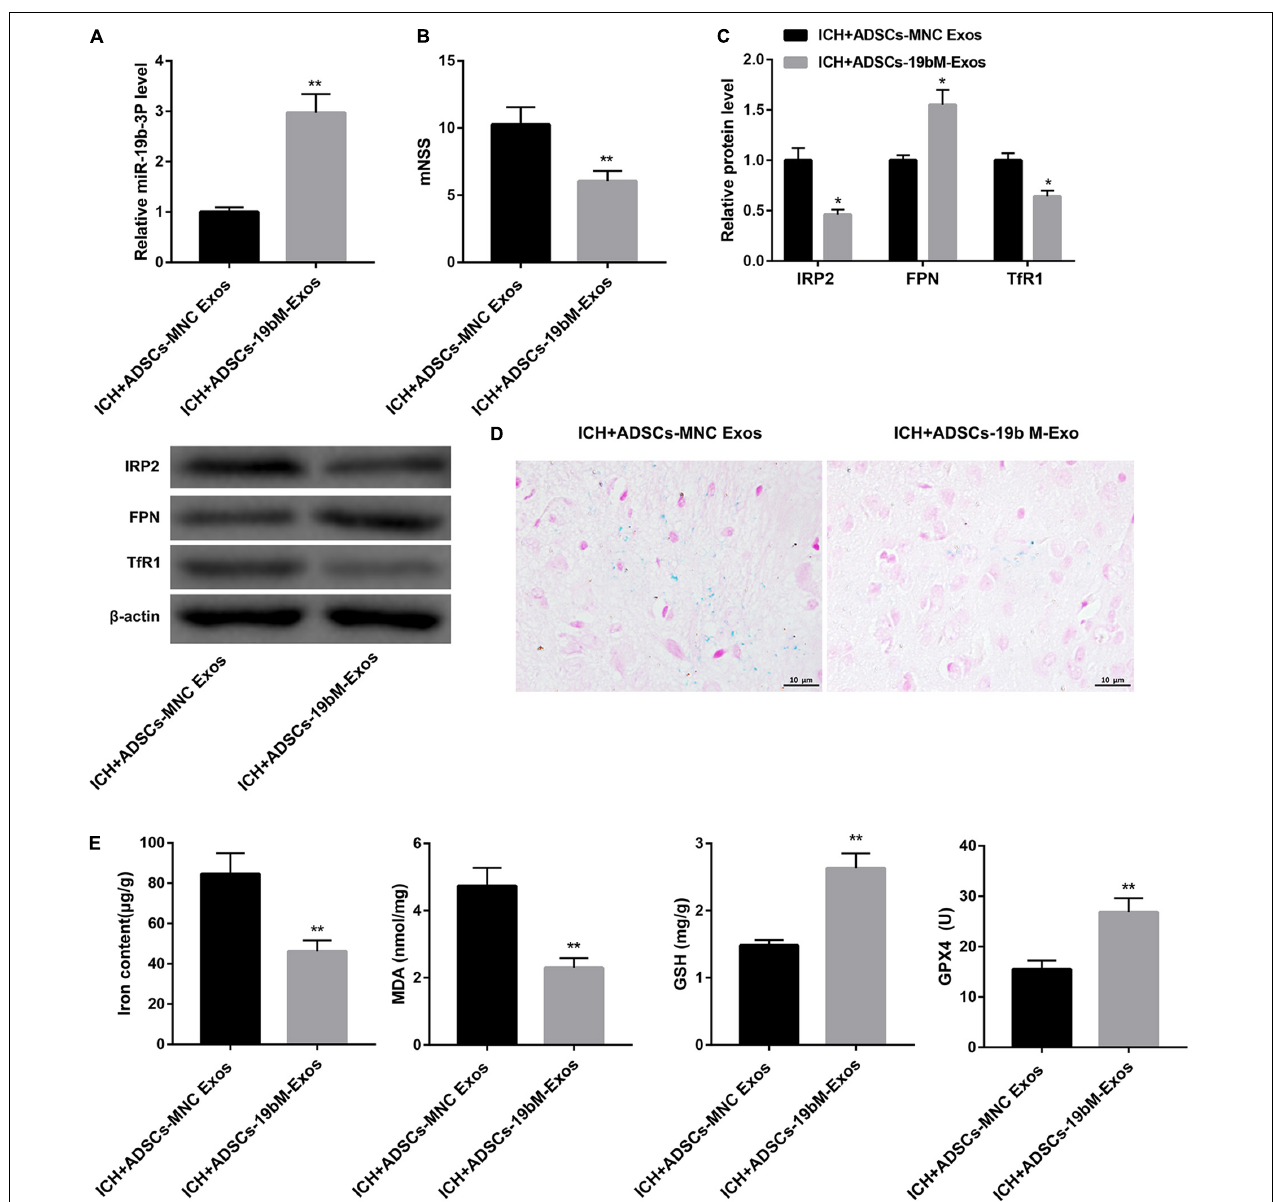
FIGURE 5 | Exosomal miR-19b-3p derived from ADSCs inhibited ferroptosis in ICH mice. Mice were randomly divided into 2 groups: ICH+ADSCs-MNC Exos and ICH+ADSCs-19bM-Exos. (A) qRT-PCR analysis of miR-19b-3p level in the plasma at 48 h after ICH in mice. (B) Neurological function at 48 h after ICH in mice was evaluated by mNSS. (C) Western blot analysis of IRP2, FPN, and TfR1 in the brain at 48 h after ICH in mice. (D) The iron deposition in the mouse brain at 48 h was determined by Perls’ Prussian blue staining (scale bar: 10 µ m). (E) The contents of iron, MDA, GSH, and GPX4 in the brain at 48 h after ICH in mice. N = 10 in each group. * P < 0.05, ** P < 0.01, vs. ICH+ADSCs-MNC